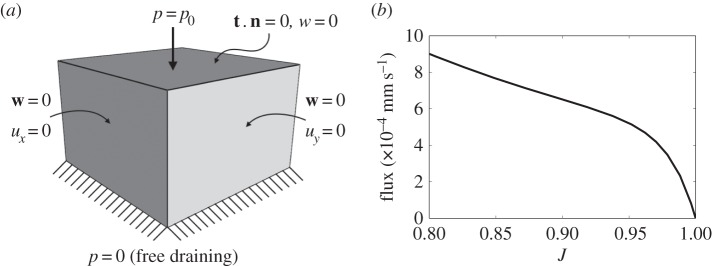
(a) Boundary conditions for the biphasic analysis. w is the water flux, p is the pressure, t is the traction vector, n is the normal vector and u the displacement. (b) Water flux variation with volume as the medial tissue is compressed. Data extracted from an element approximately 10 µm from the fixed surface.